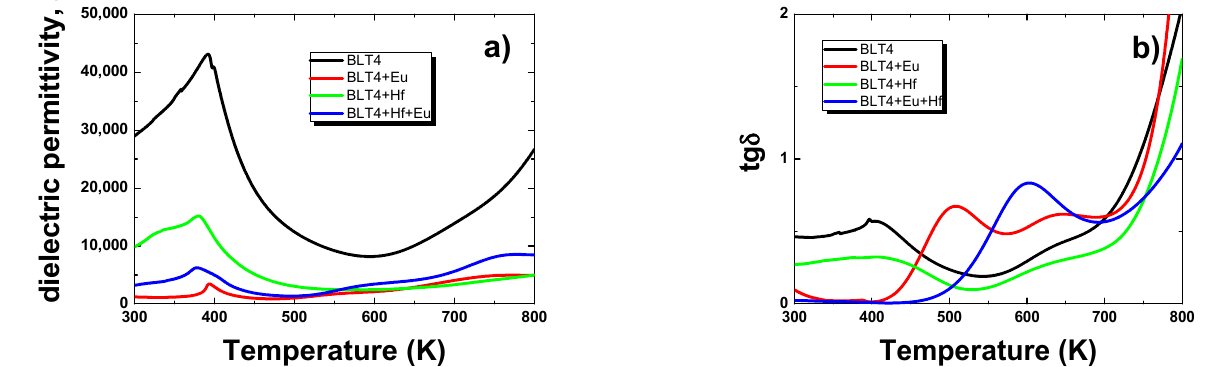
Figure 3. Dielectric permittivity ( a ) and loss tangent ( b ) as a function of temperature, measured at a frequency of 1 kHz, for pure and modified BLT4 ceramics.